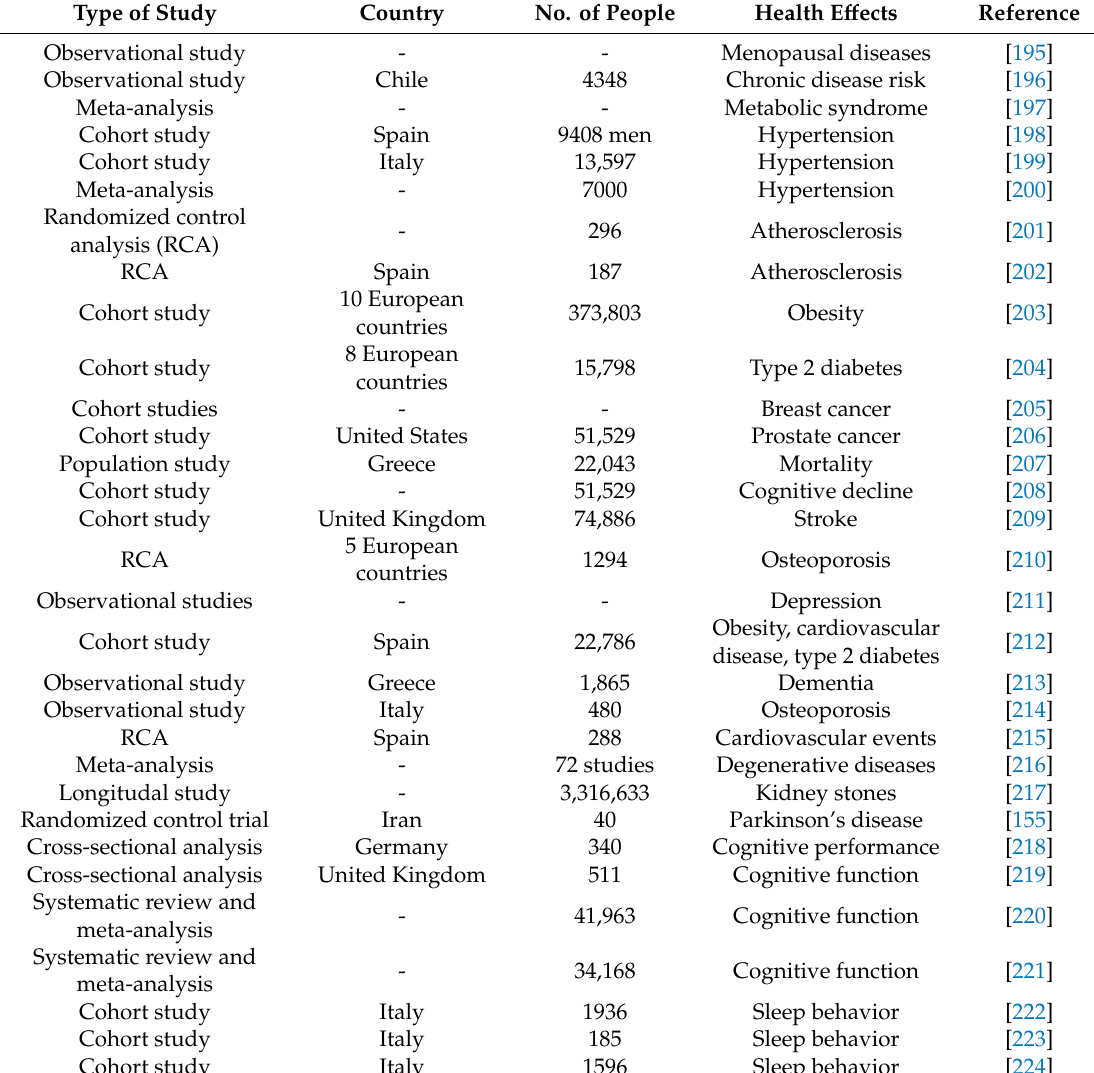
Table 1. Representation of di ff erent types of studies involving humans, in which positive e ff ects of the consumption of the Mediterranean diet were found. Some references focus on various published studies and thus the number of people and countries where the study was carried out are not